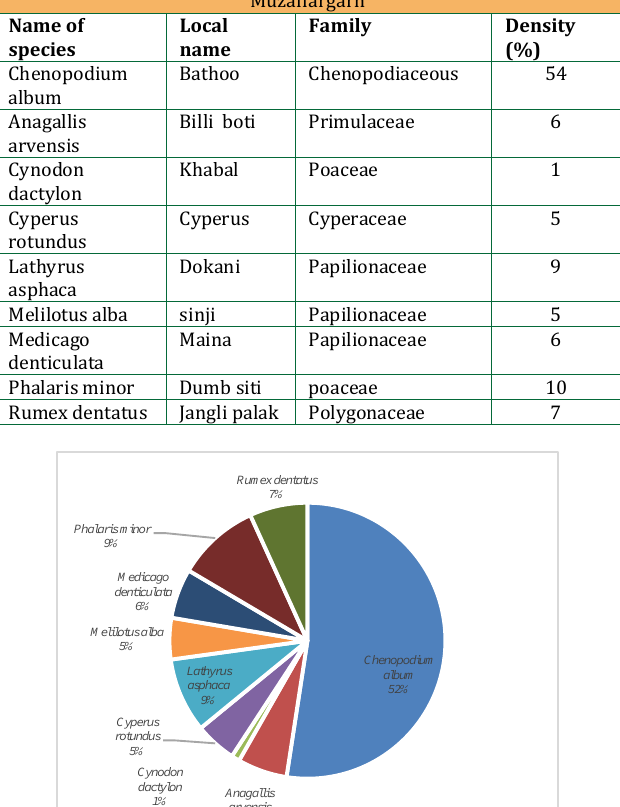
Figure 11: Frequency of weed infesting wheat field at Sultan Nagar district Muzaffargarh Table 12: Density of weeds infesting wheat field Sultan Nagar District Muzaffargarh